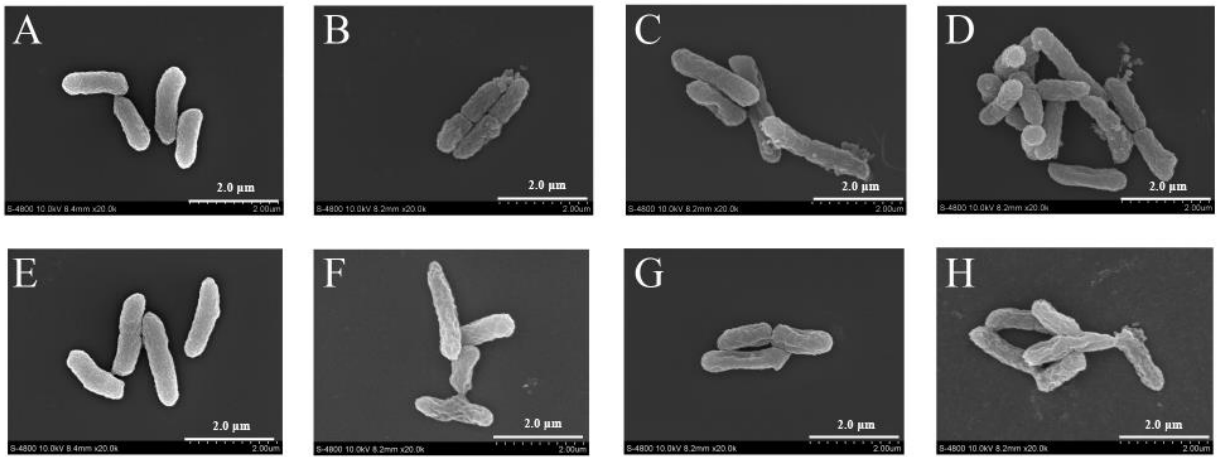
Figure 6. FESEM images of C. sakazakii with LC-EO treatment at 0MIC for 0.5 h ( A ), 1/4MIC for 0.5 h ( B ), 1/2MIC for 0.5 h ( C ), MIC for 0.5 h ( D ), 0MIC for 1 h ( E ), 1/4MIC for 1 h ( F ), 1/2MIC for 1 h ( G ), and MIC for 1 h ( H ).